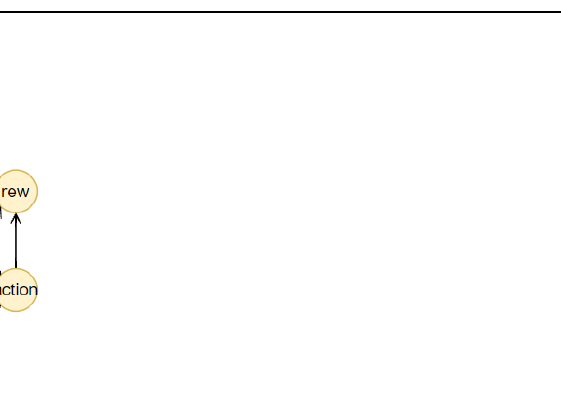
Figure 7. Structure of the BN for Taxi environment where each node represents a feature: “dest” is the destination, “pass” is the passenger position, “taxi col” is the taxi column, “taxi row” is the taxi row, “action” is the action, “rew” is the reward, “next dest” is the next value for the destination, “next pass” is the next value for the passenger position, “next col” is the next value for the taxi column and “next row” is the next value for the taxi row.